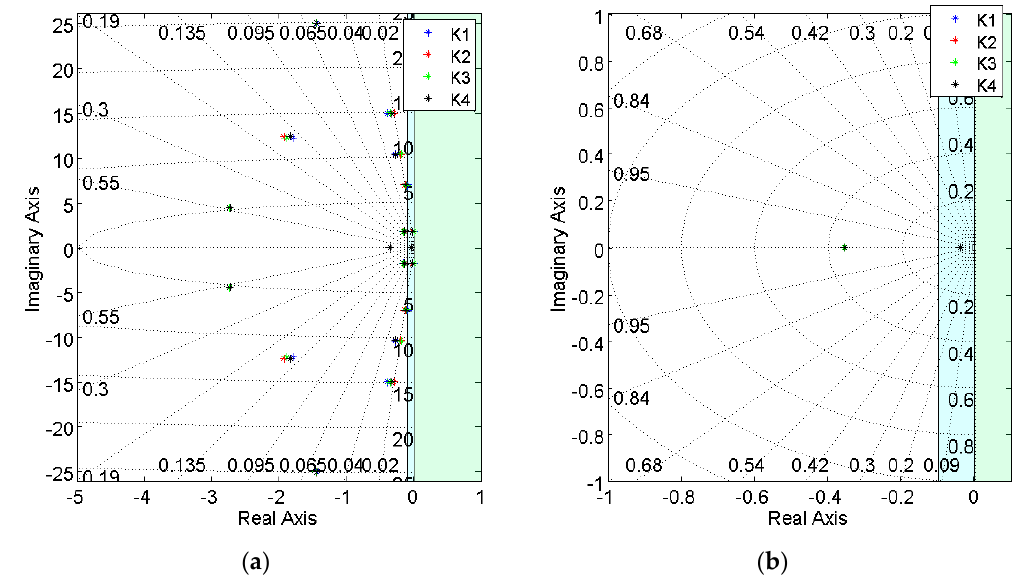
Figure 9. Pole map of the Kharitonov polynomials. 7th order LTI pitch model, ∆𝛽 = 2° and 𝑞 (cid:2872) ( a ) Original view ( b ) Detailed view.